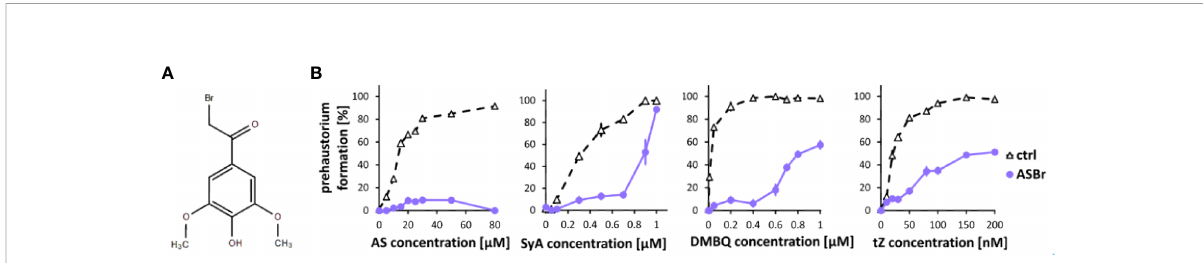
FIGURE 2 Effects of ASBr on prehaustorium induction triggered by syringic acid, quinone or cytokinin. (A) Chemical structure of a -bromoacetosyringone (ASBr), an inhibitor of AS in inducing virA-mediated vir genes in Agrobacterium for tumor induction. (B) S. hermonthica seedlings were treated by AS, SyA, DMBQ and a cytokinin trans -zeatin (tZ) at the concentrated indicated on the horizontal axis in the absence (ctrl) or presence of 10 µM ASBr for 24 h. Data represents mean ± SE with three